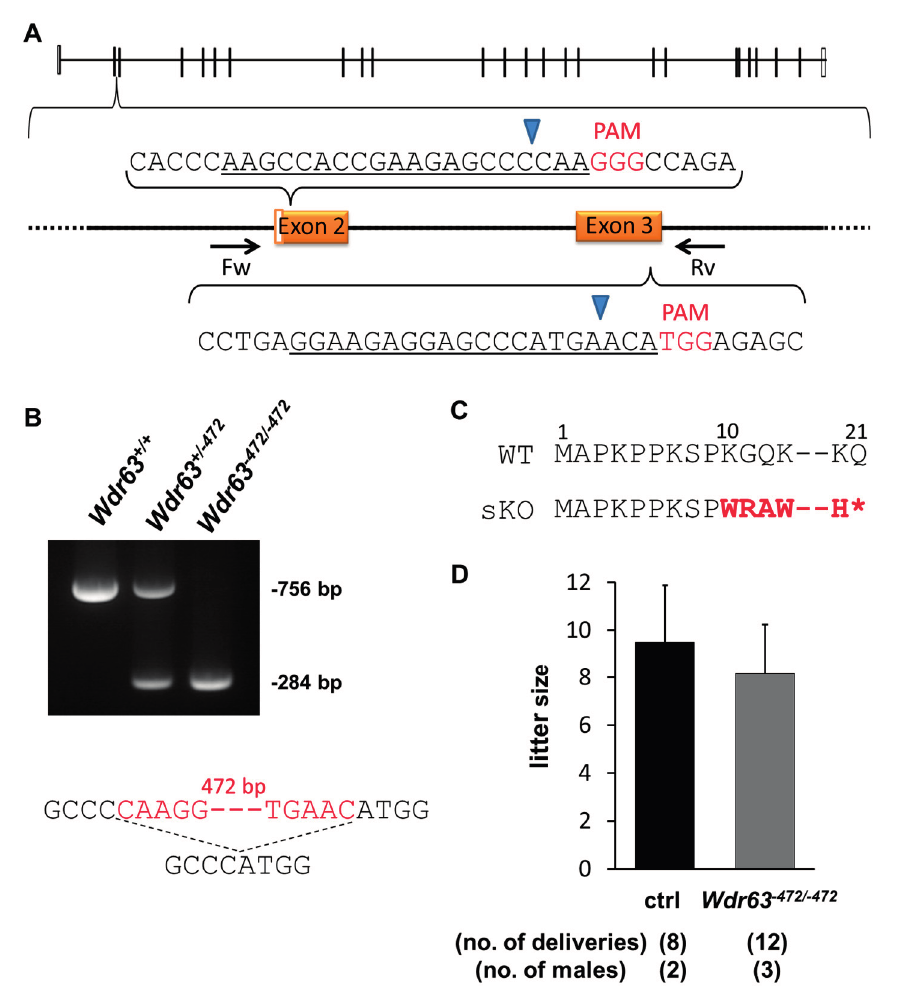
Figure 3. CRISPR/Cas9 strategy and results for Wdr63 − 472/ − 472 male mice. ( A ) Wdr63 exons 2 and 3 were targeted; coding exons shown as solid black bars, non-coding exons shown as open bars. Forward (Fw) and reverse (Rv) primers for validation and genotyping shown; black arrows labelled Fw and Rv. sgRNA sequence underlined in black. PAM sequence is shown in red. Blue arrowhead indicates site of Cas9 digestion; ( B ) PCR of WT, heterozygote ( Wdr63 +/ − 472 ) and homozygote ( Wdr63 − 472/ − 472 ) mice; Sequence showing part of deleted region; deleted region in red (472 bp in length); dashed line indicates deleted region; ( C ) Frameshift mutation of Wdr63 − 472/ − 472 mice, mutation shown in red, * indicates a premature stop codon. Amino acid number shown above sequence; ( D ) Natural mating analysis of Wdr63 − 472/ − 472 male mice with WT